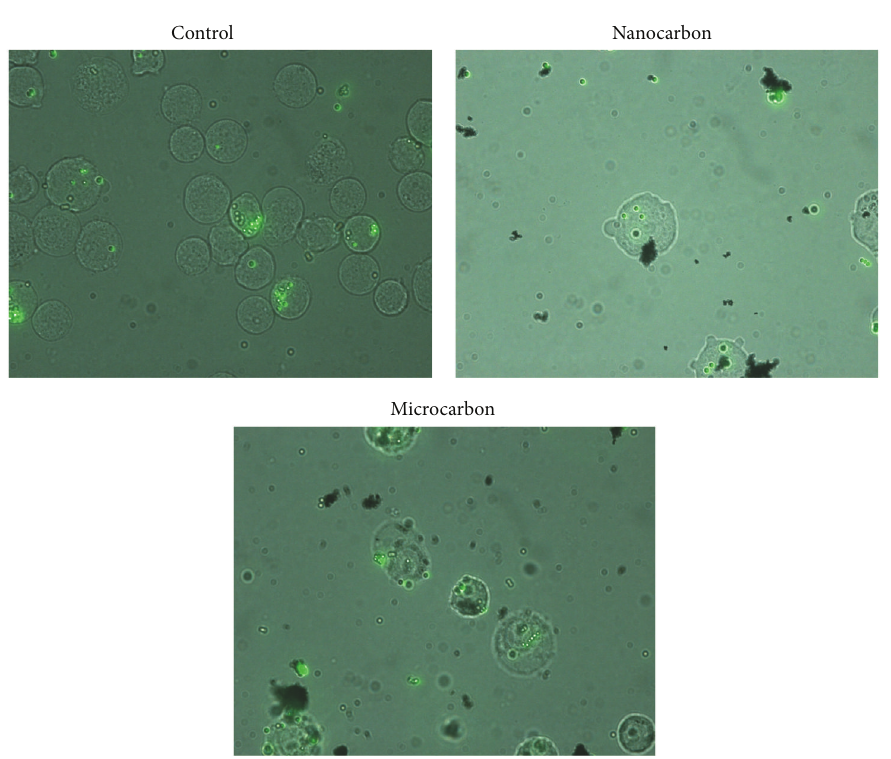
Figure 4: Representative photomicrographs of THP-1 cells phagocytosing latex beads (magnification 1000x).